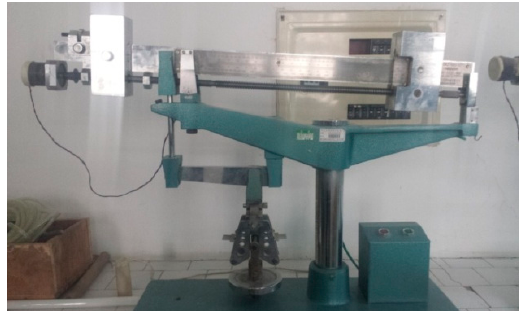
Figure 1. Electric flexure tester.